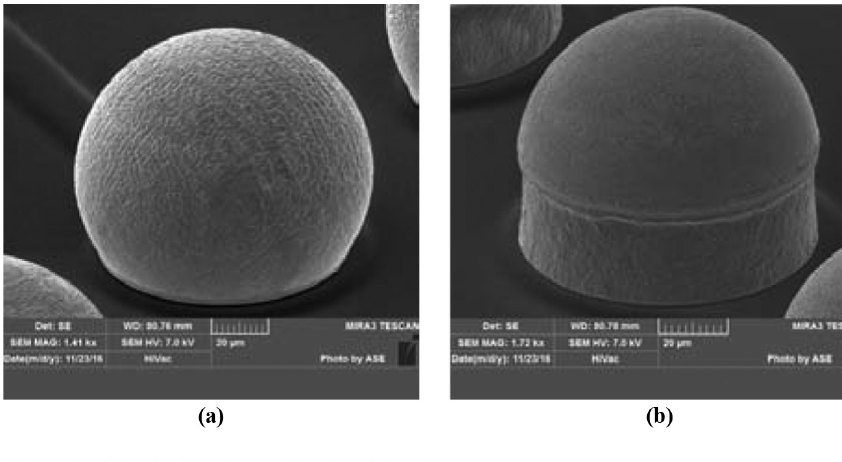
Figure 3. SEM of bumped die